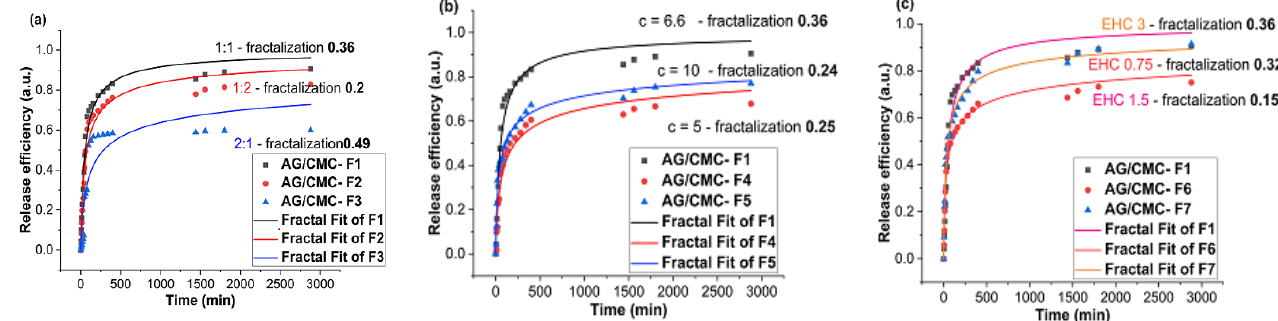
Figure 5. Comparative plots of fractal fits for different release kinetics: ( a ) F1, F2, F3 films, ( b ) F1, F4, F5 films, ( c ) F1, F6, F7 films. The calibration of the model is described in Figure 6 where the efficiency of the system is plotted as a function of the fractalization degree as given by the model. An exponential function proved to be the best calibration fit.